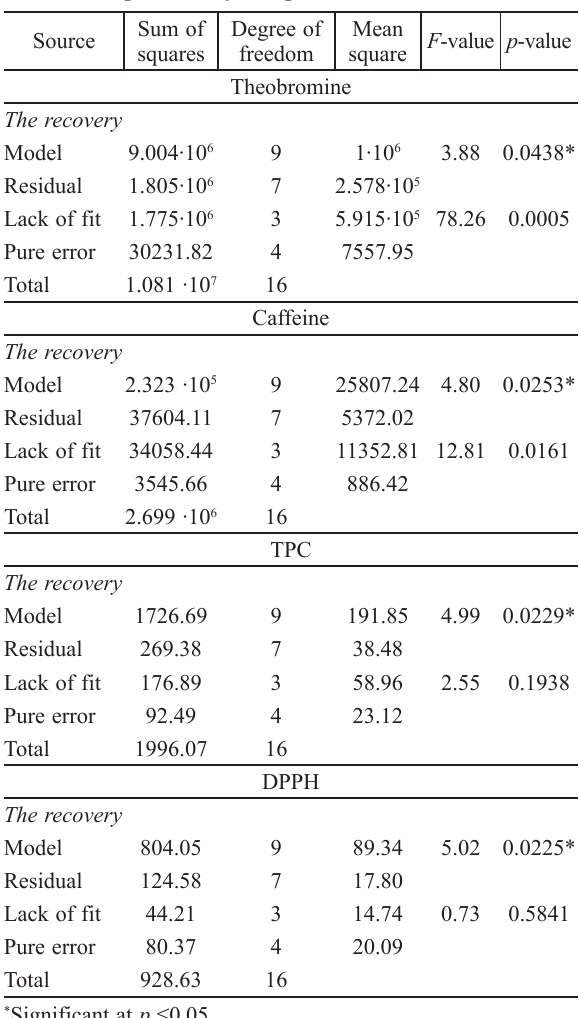
Table 4 – Regression coefficients of the polynomial function of theobromine and caffeine content, total phenolic content and DPPH assay